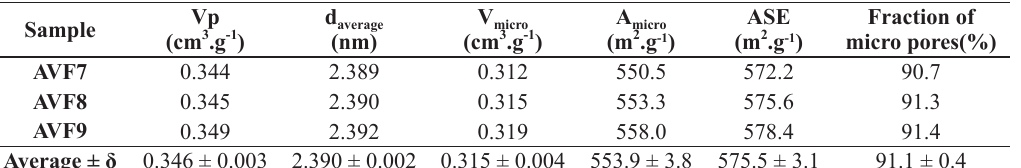
Parameters of the porous structure of AVFs activated under a heating rate of 10 °C.min -1 .